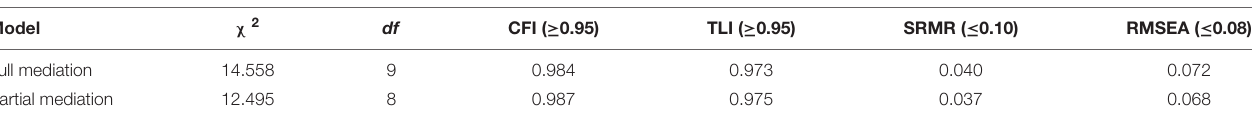
TABLE 3 | Model fit indices for latent variable mediation